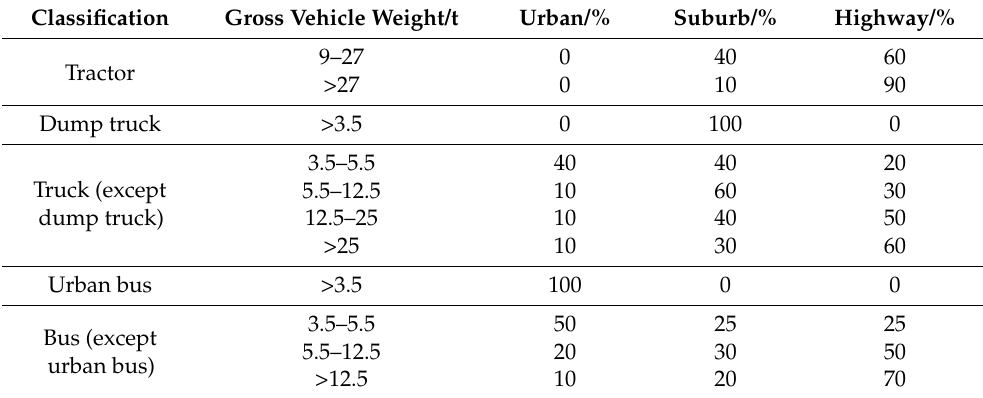
Table 1. Weighting coefficients in the China third stage fuel consumption